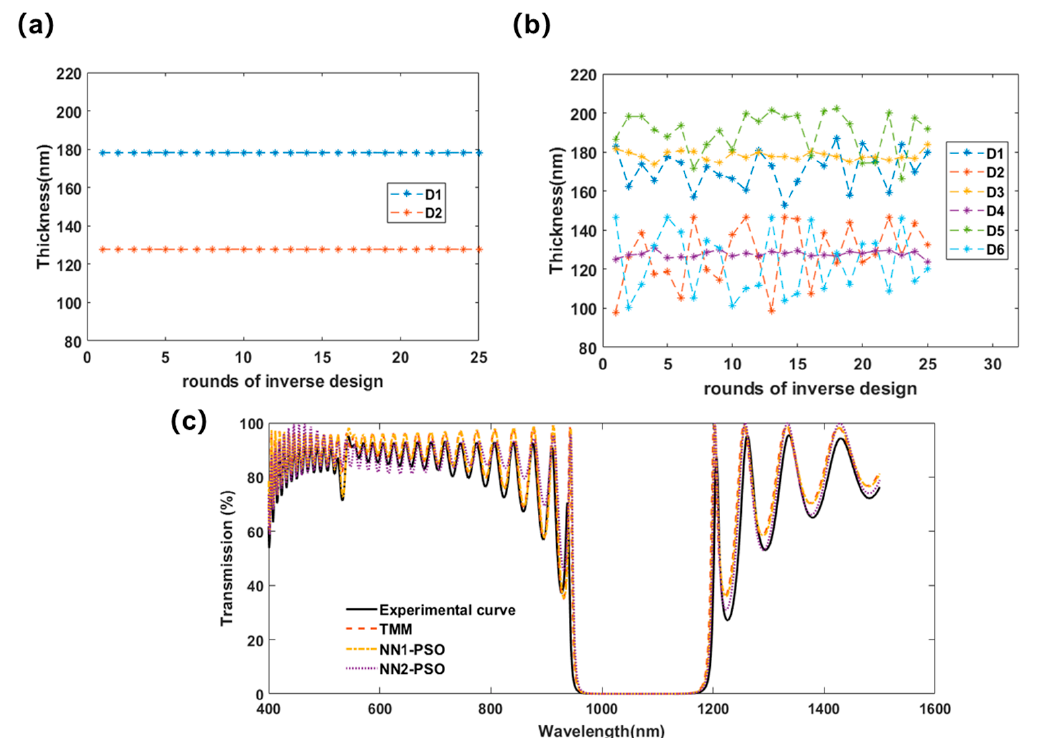
Figure 11. ( a , b ) The result distribution statistics for the two NNs, and ( c ) the transmission spectra from the experimental measurement, from TMM simulation for the preset grown structure, and from NN1(/2)-PSO’s predictions.